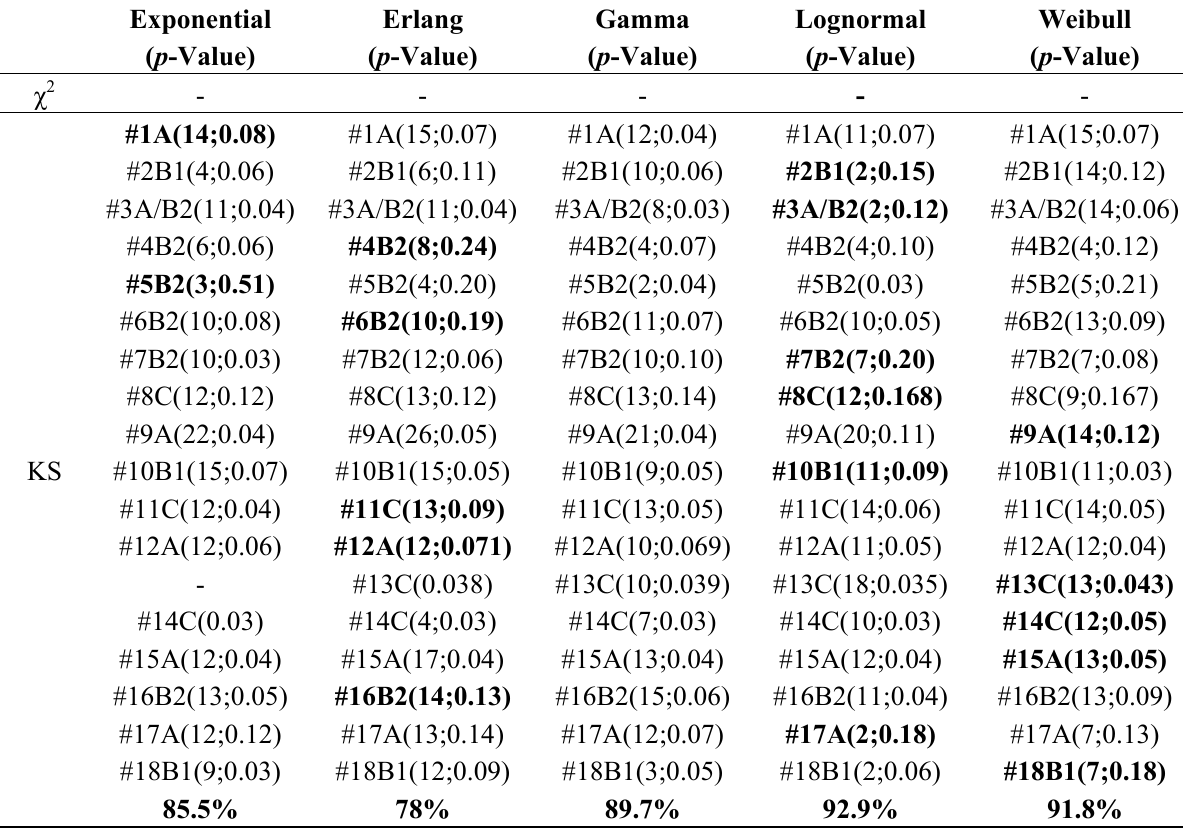
Table 8. Results obtained with the near-optimal change detection algorithm. The items marked in bold have the best p-value of their corresponding row, i.e. , they are the best models found for that